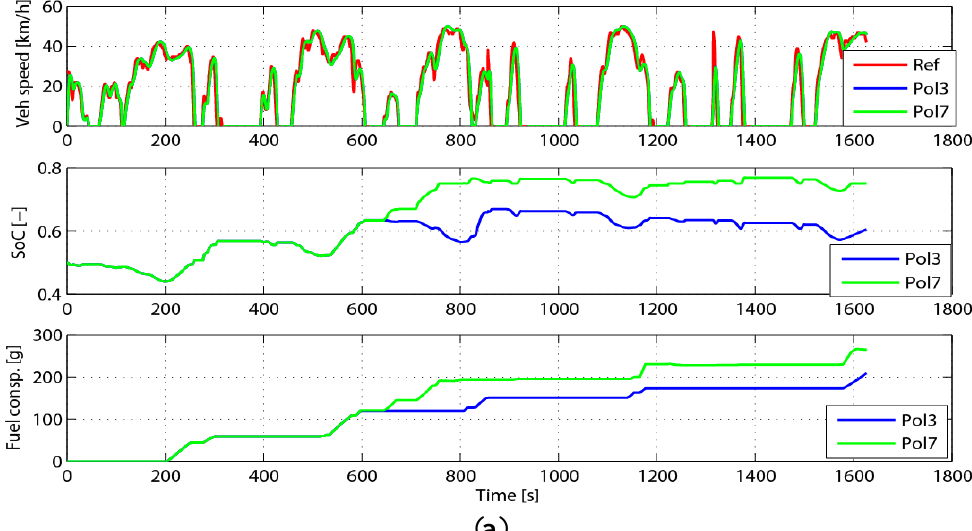
Figure 18. Comparison of the policy-3 and the policy-7 in the third segment driving data. ( a ) Vehicle speed, SoC and fuel-electricity consumption; ( b ) engine operating point